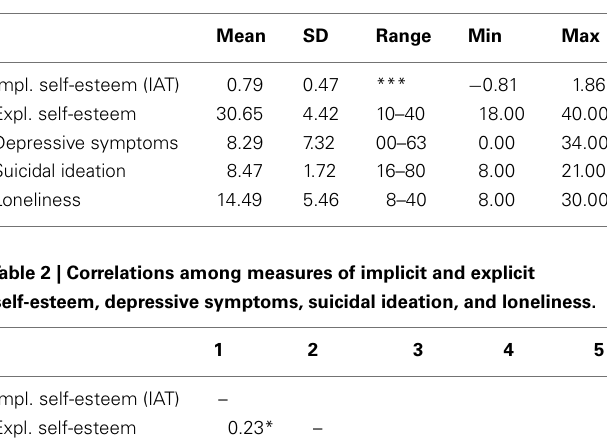
Table 1 | Descriptive statistics for measures of implicit and explicit self-esteem, depressive symptoms, suicidal ideation, and loneliness.